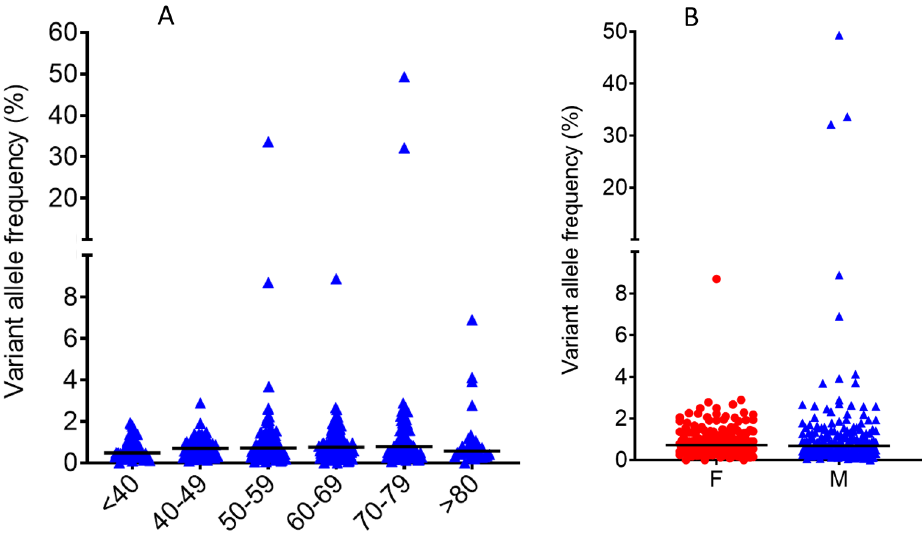
Figure 3. Effects of age ( A ) and gender ( B ) on non-coding mutations in non-BC haematuria clinic patients. The data are non-coding hotspot maximum VAFs in individual cpDNAs (all non-BC patients). Horizontal bars represent median values.